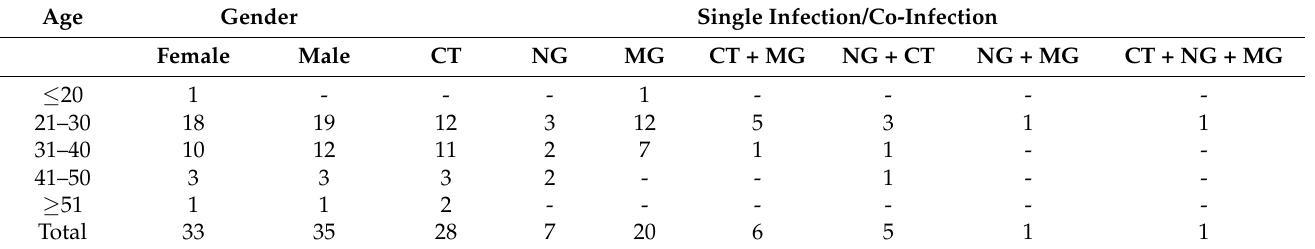
Table 2. Distribution of single infections and co-infections according to the age and gender of the infected patients ( n ).